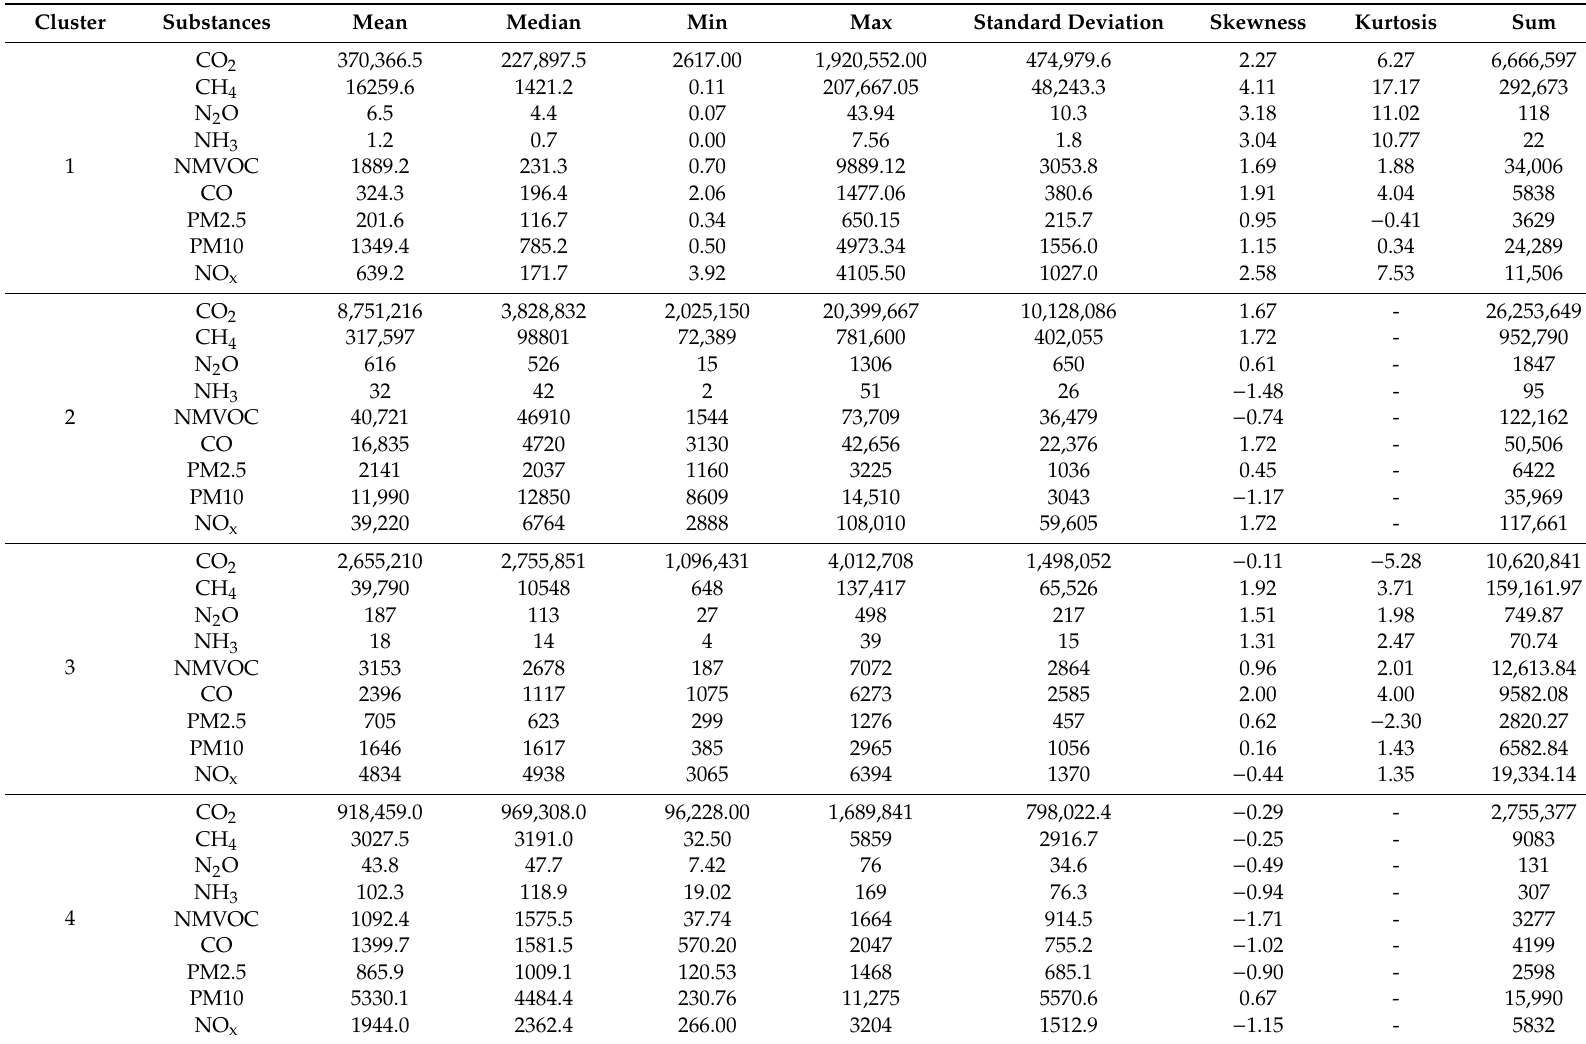
Table 8. The results of the statistical analysis regarding the absolute emission values of studied substances from the mining and quarrying sector for individual clusters of the EU countries (own